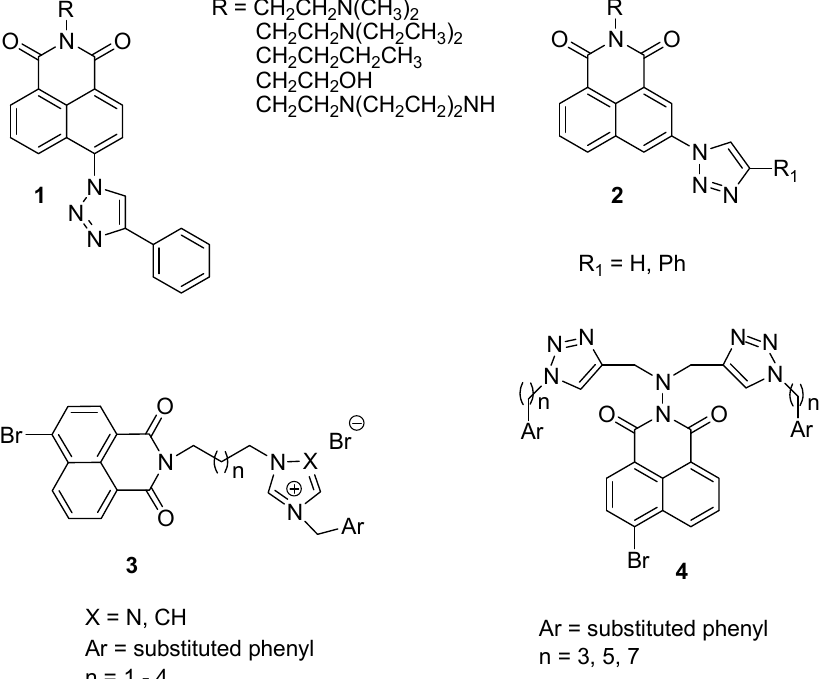
Figure 1. Examples of naphthalimides containing triazole units.